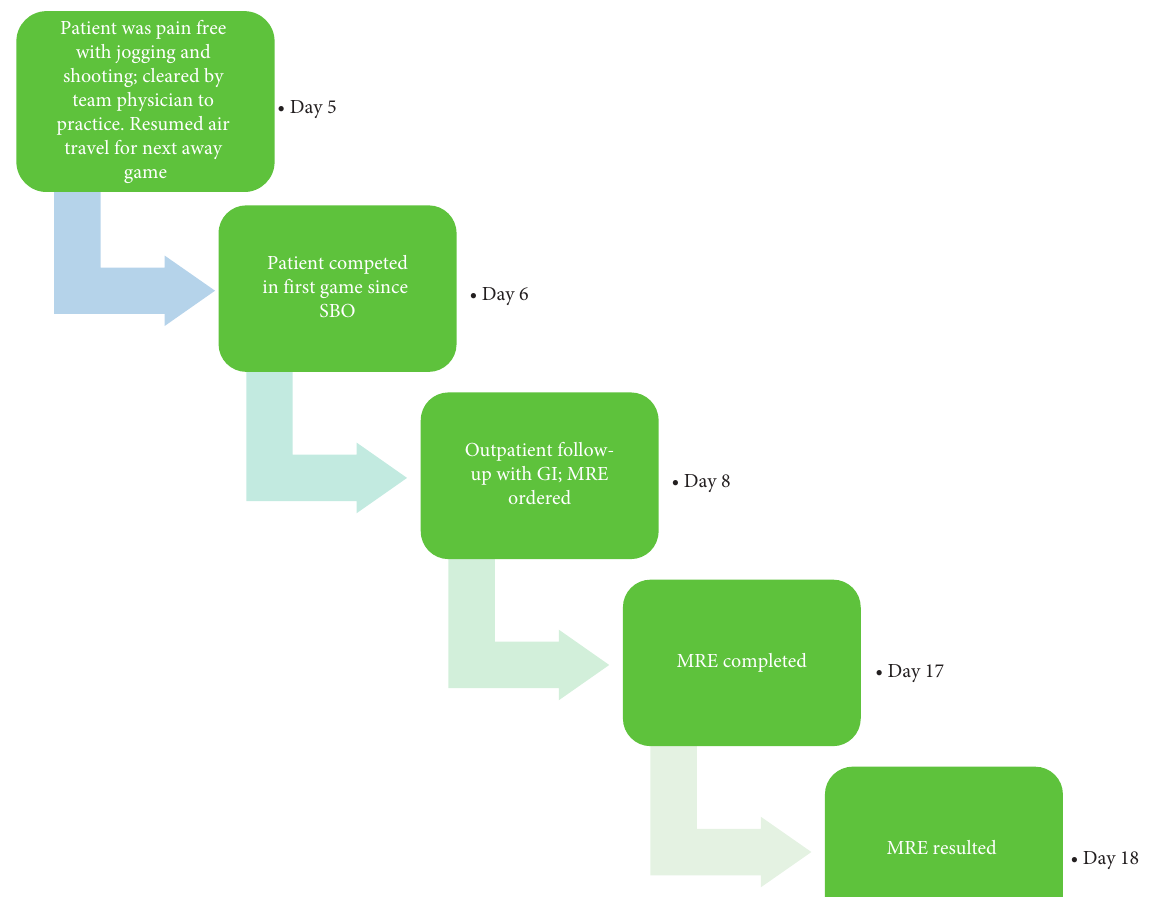
Figure 4: Chronologic depiction of return to play (RTP) and outpatient follow-up with days calculated since the time of symptom onset defined as day 0. SBO, small bowel obstruction; GI, gastroenterology; MRE, magnetic resonance